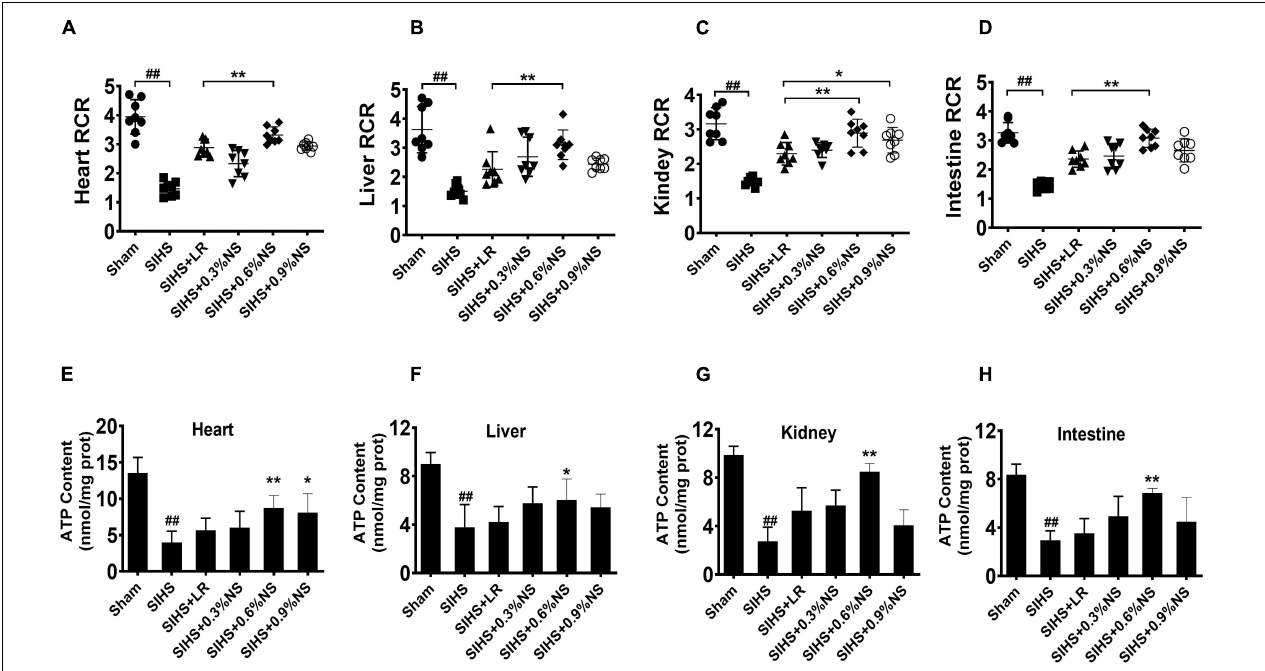
FIGURE 4 | Effects of different osmotic fluids on mitochondrial function with seawater immersion in hemorrhagic shock rats ( n = 8/group). (A) Mitochondrial respiratory control rate of the heart. (B) Mitochondrial respiratory control rate of the liver. (C) Mitochondrial respiratory control rate of the kidney. (D) Mitochondrial respiratory control rate of the intestines. (E) ATP contents of the heart tissue. (F) ATP contents of the liver. (G) ATP contents of the kidney. (H) ATP contents of the intestine. Sham, Sham-operated group; SIHS, seawater immersion combined with hemorrhagic shock; LR, lactated Ringer’s solution; NS, normal saline; RCR, respiratory control rate. * p < 0.05 and ** p < 0.01, compared with the LR group. ## p < 0.01, compared with the Sham